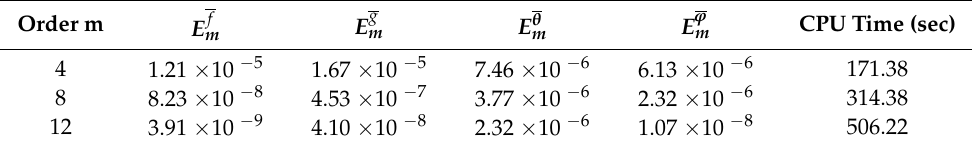
Table 2. Individual averaged squared residual errors with optimized values at m = 8 from Table